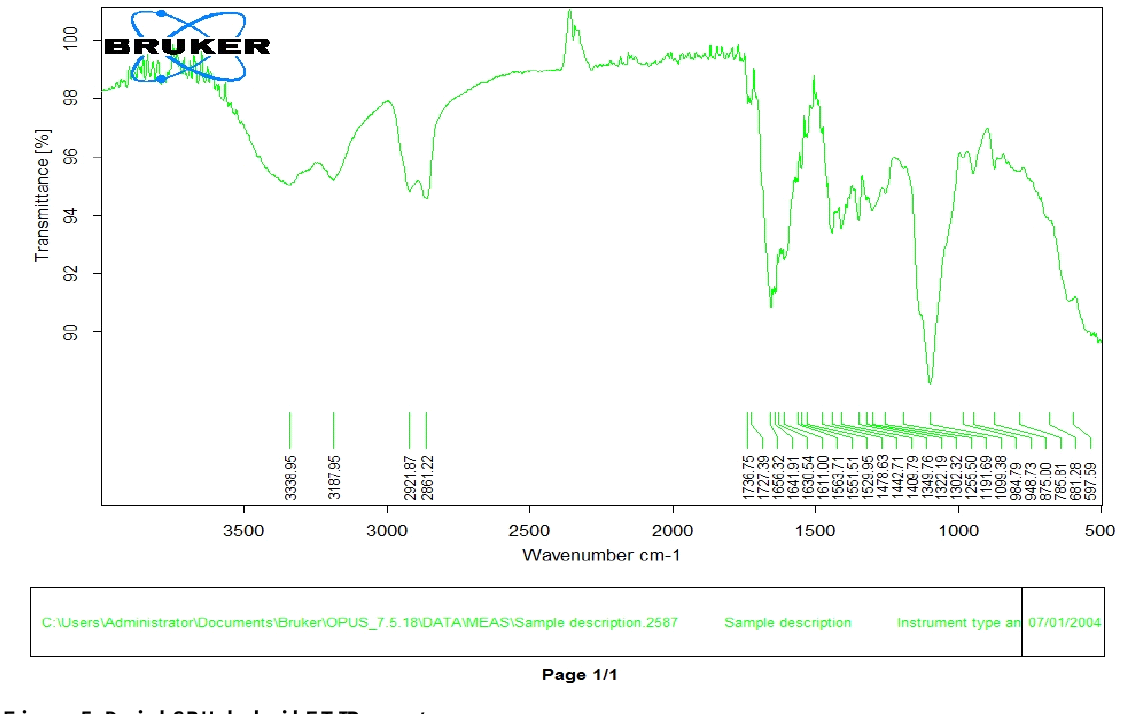
Figure 5. Dried SPH hybrid FTIR spectru Table 9 Variation in FTIR Analysis of Carvedilol and SPH Hybrid (F8) No. Assignment